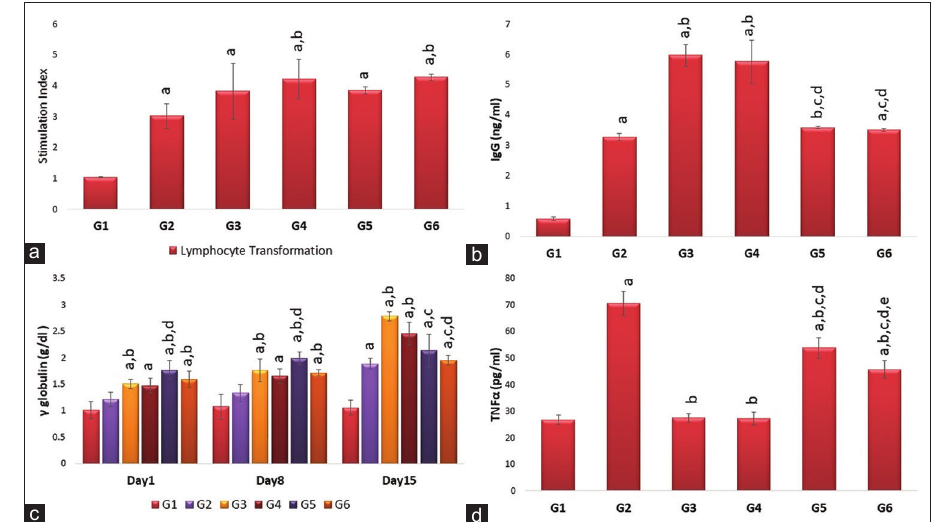
Figure-4: (a-d) Effects of single and repeated intravenous injection of 300 μ g/kg body weight 50 nm either gold nanosphere or gold nanorods in male rabbits on γ -globulin, lymphocyte transformation on day 8 and immunoglobulin G and tumor necrosis factor-alpha on day 15. Means carrying superscripts are significantly different at p<0.05 based on Tukey’s honestly significant difference. a=Significantly different versus G1, b=Significantly different versus G2, c=Significantly different versus G3, d=Significantly different versus G4, and e=Significantly different versus G5.